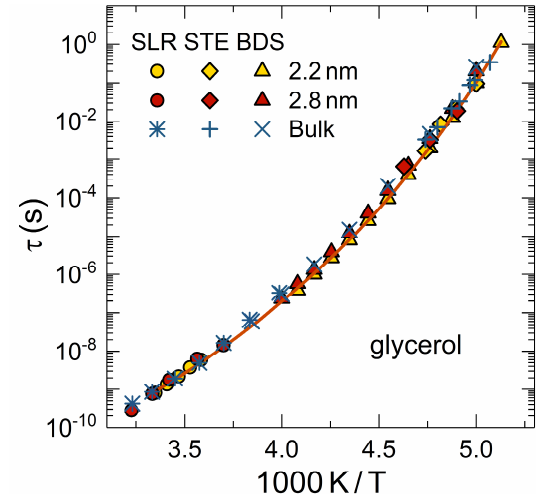
Figure 6. Temperature-dependent correlation times of glycerol-d 5 in the bulk liquid and in MCM-41 pores with the indicated diameters. Results from 2 H NMR (spin-lattice relaxation and stimulated-echo experiments) and BDS are compared. The solid line is an interpolation with a Vogel-Fulcher-Tammann relation.